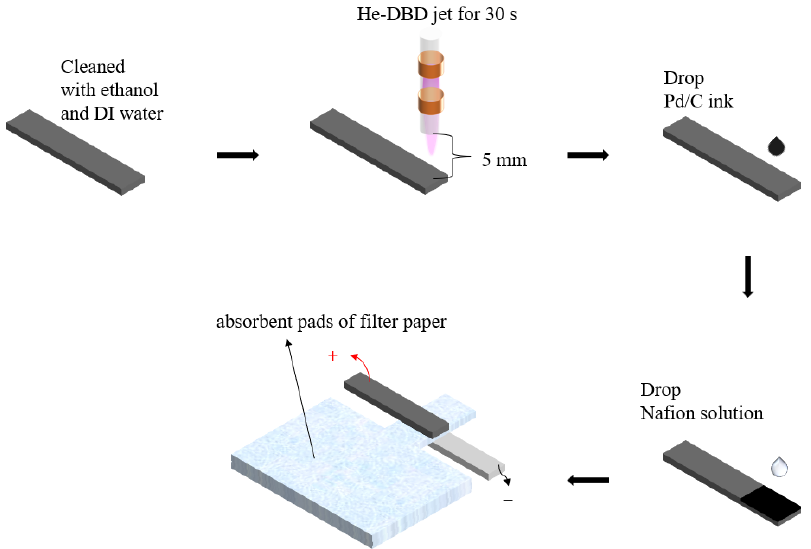
Figure 2. Flowchart of the Al-air battery fabrication process.